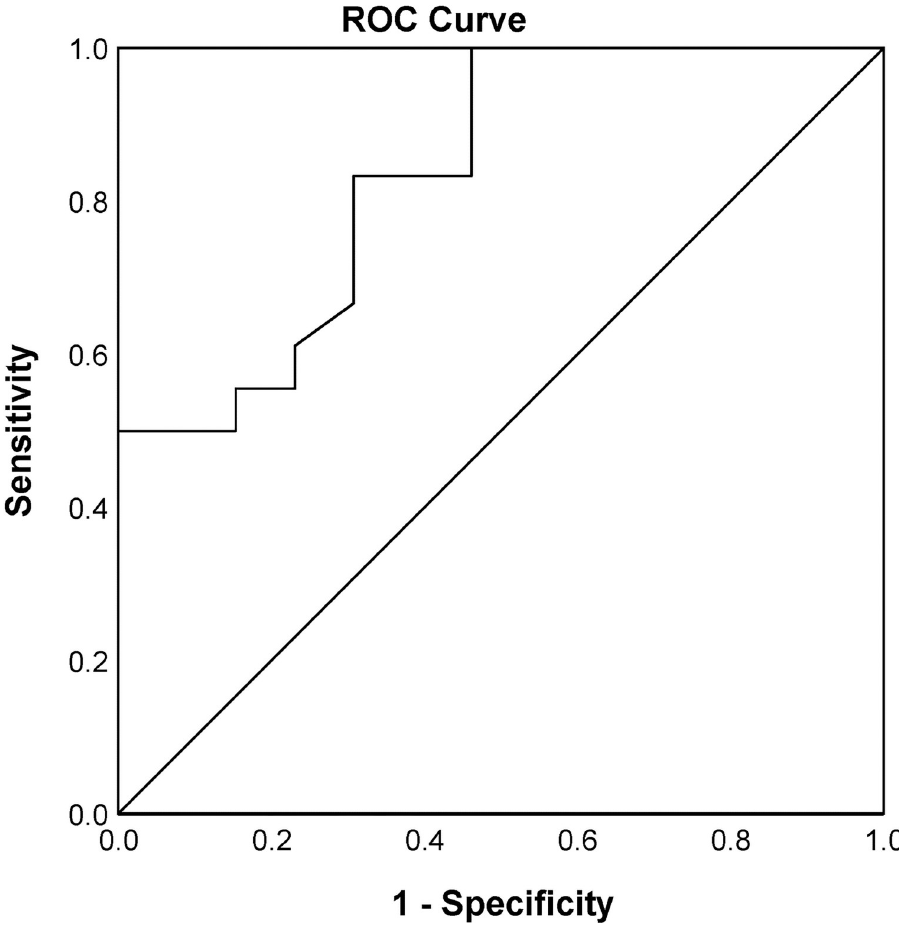
Fig 4. ROC analysis of mtDNA-CN. ROC curve was generated to evaluate the diagnostic value of mtDNA-CN as a biomarker for psoriasis. The AUC for discriminating psoriasis patients from healthy controls was 0.84 (95% CI: 0.694– 0.977, P =